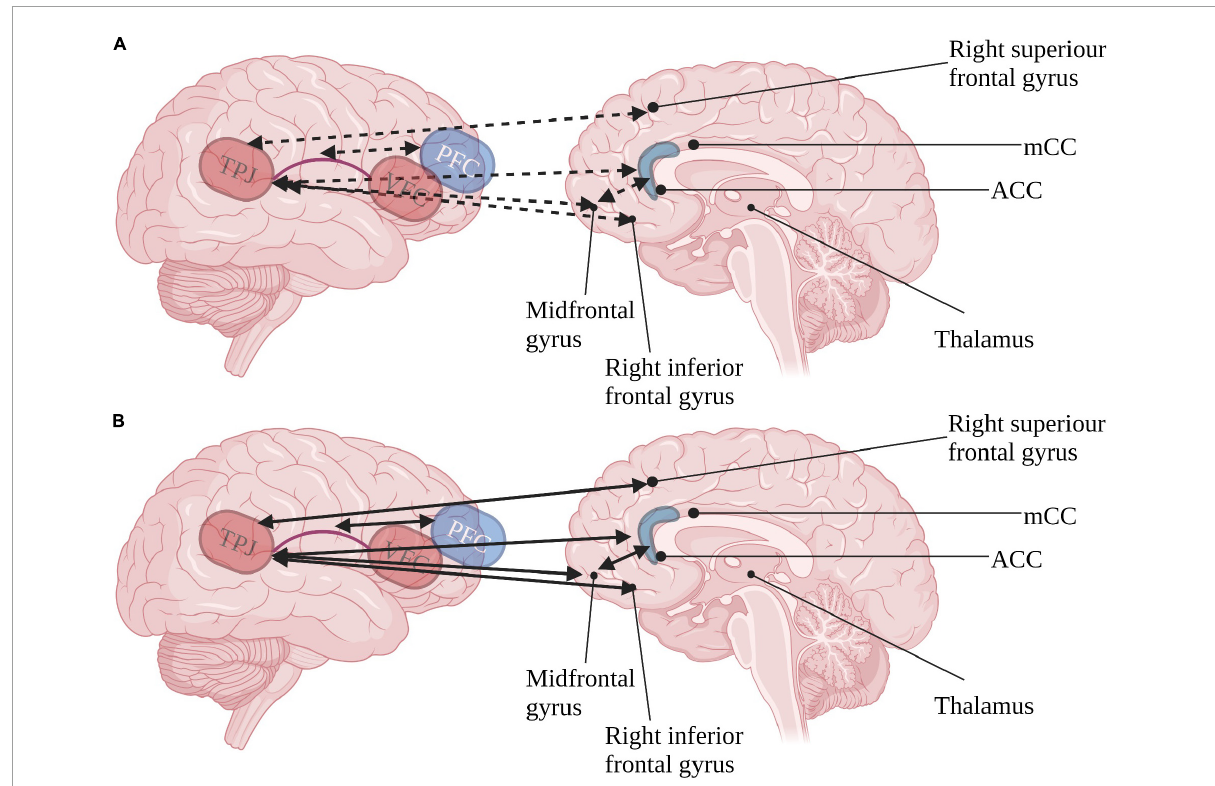
FIGURE2 Inter-relations of ventral orienting (red) pathway and executive attention (blue) pathways in (A) typical development and (B) ASD. Continuous arrows represent positive correlations, dashed arrows represent negative correlations. TPJ, tempotoparietal junction; VFC, ventral frontal cortex; PFC, prefrontal cortex; ACC, anterior cingulate cortex; mCC, medial anterior cingulate. Created with